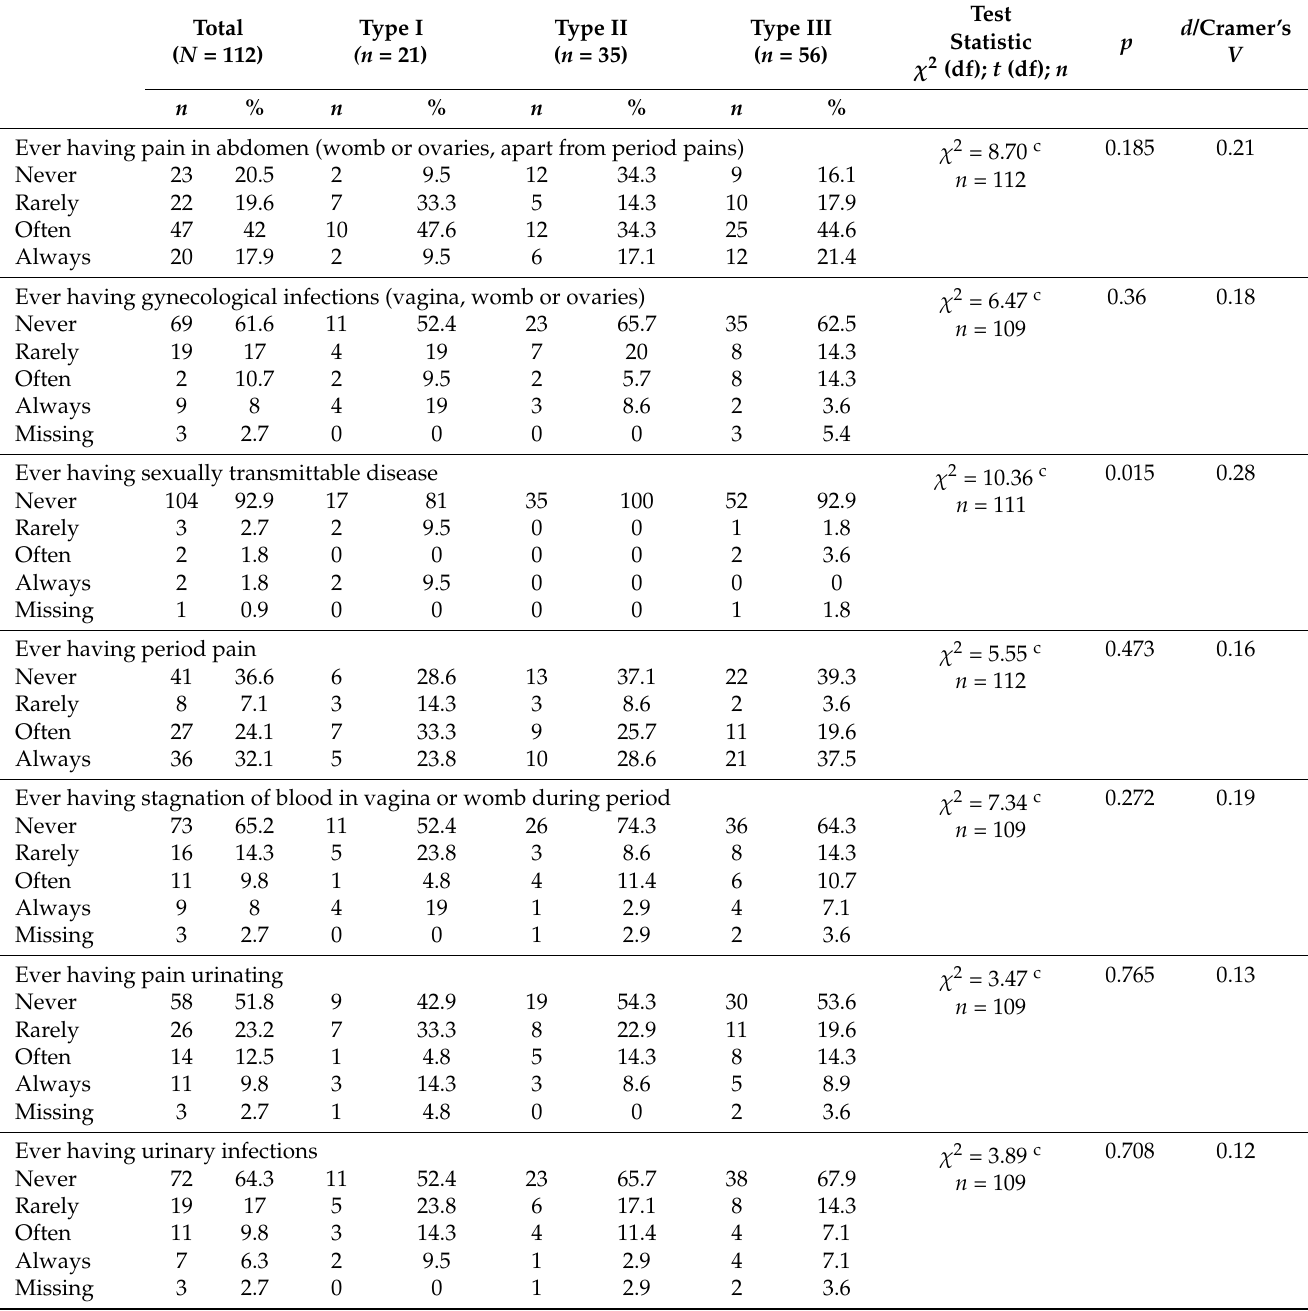
Table 2. Excerpt of physical